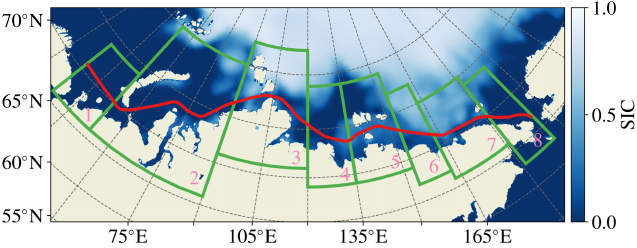
Figure 1. The NSR (red line) and representative sub-regions, as defined in the text, with sea ice conditions chosen from the ERA5 single-level monthly mean values for the date 1 July 2019.